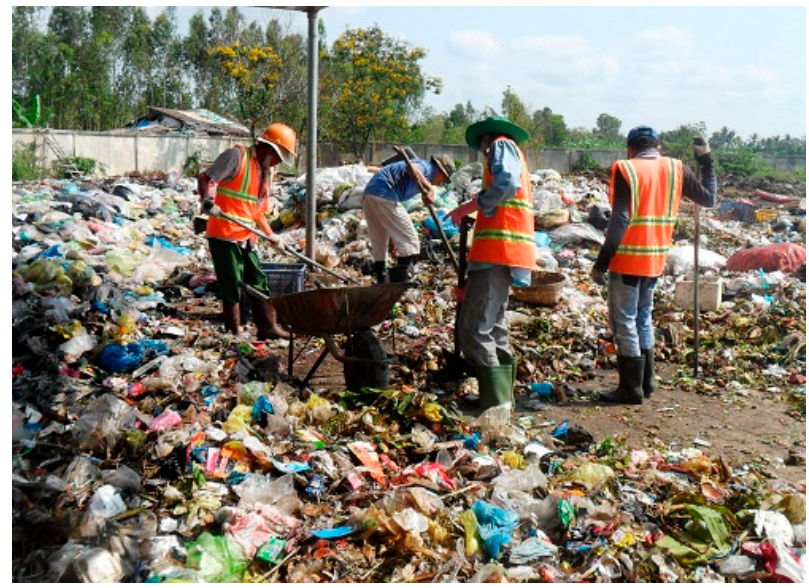
Figure 5. Solid waste in Vietnam.